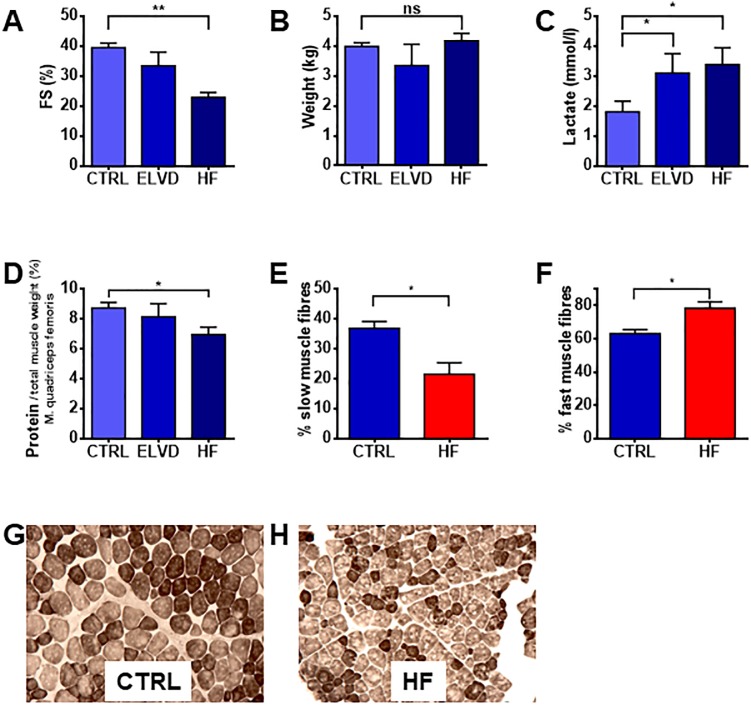
Tachypacing leads to systolic heart failure and signs of sarcopenia.Rapid ventricular pacing caused left ventricular dysfunction (A). Body weight remained stable (B), due to ascites and pleural effusion in HF. Heart failure syndrome was accompanied by raising lactate levels (C), decreased protein content of LM (D) and a slow-to-fast fibre type switch (E, F), which is depicted by representative slices (G, H): after specific inhibition of ATPase by alkali (type I fibres) and acid (type II fibres), ATPase staining shows dark slow and light fast fibres. A-C: paired t-test n = 5 for each group; D: paired t-test n = 3 for each group; E, F: Welch’s unequal variances t-test. *p<0.05, **p<0.01. n(CTRL/HF) = 6/3. FS: fractional shortening. CTRL: control. ELVD: early left ventricular dysfunction. HF: heart failure. LM: limb muscle.